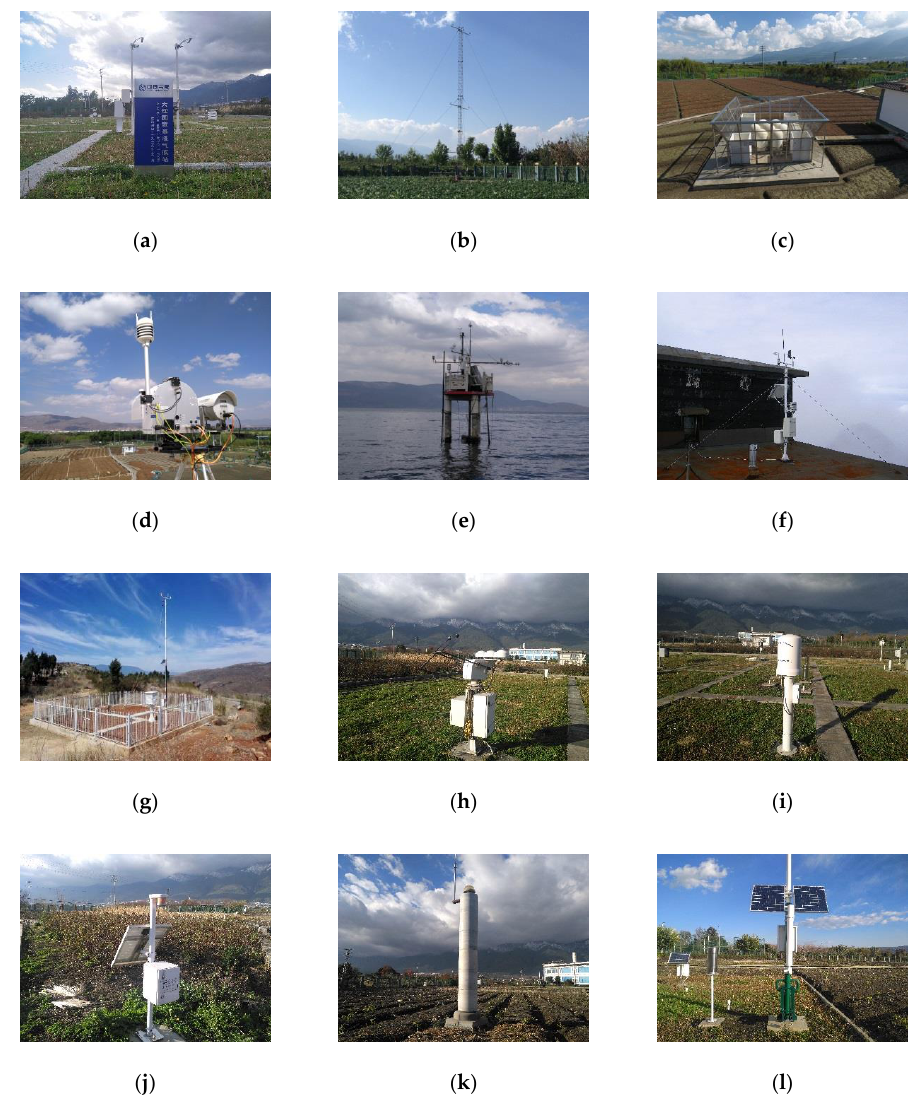
Figure 3. Instruments of the integrated meteorological observations at the DNCO. ( a ) Dali National Reference Climatological Station; ( b ) 20-m planetary boundary layer tower; ( c ) wind profiler radar; ( d ) optical and microwave scintillometer; ( e ) observation platform over Erhai Lake; ( f ) typical profile observation of mountain meteorology (e.g., Dianshizhuanbotai site); ( g ) automatic weather stations around Erhai Lake (e.g., Wase site); ( h ) baseline surface radiation observation; ( i ) lightning location detector; ( j ) atmospheric electric field mill; ( k ) ground-based Global Position System (GPS) water vapor system; ( l ) cosmic-ray soil moisture observing